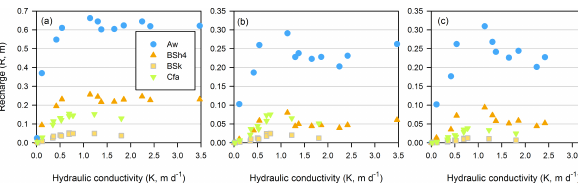
Fig. 2. Modelled annual recharge ( R ) under soils with various hy- draulic conductivity (soil hydraulic conductivity is estimated as K = k t m t + k s m s , where k i and m i are hydraulic conductivity and m t + m s thickness of topsoil ( t ) and subsoil ( s )) for three types of land cover: (a) annuals, (b) perennials and (c)